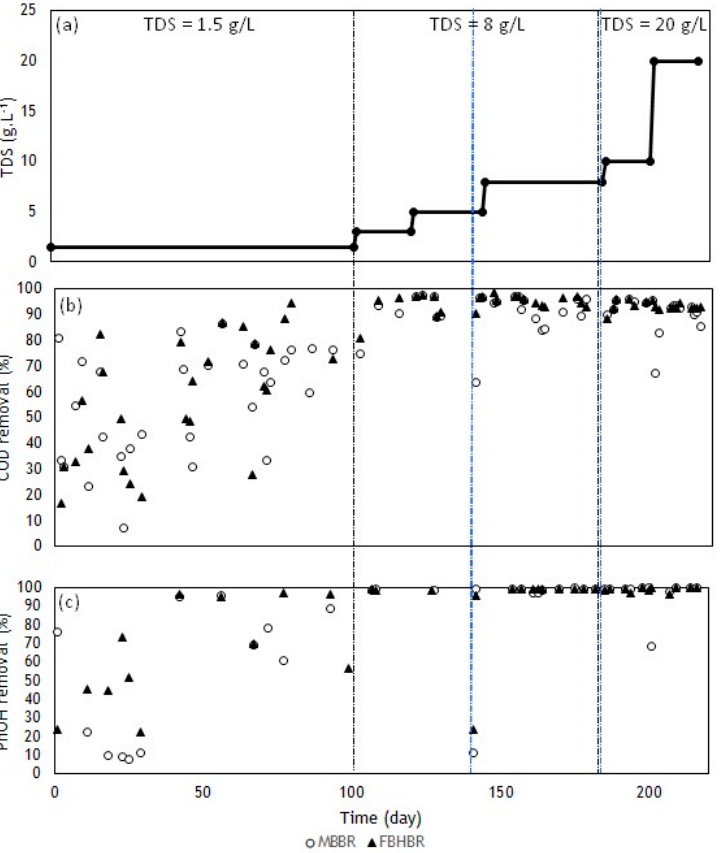
Figure 5. Evolution of COD removal efficiency and phenol removal efficiency in both MBBR and FBHBR during the experiment: TDS concentration ( a ), COD removal ( b ) and phenol removal ( c ).